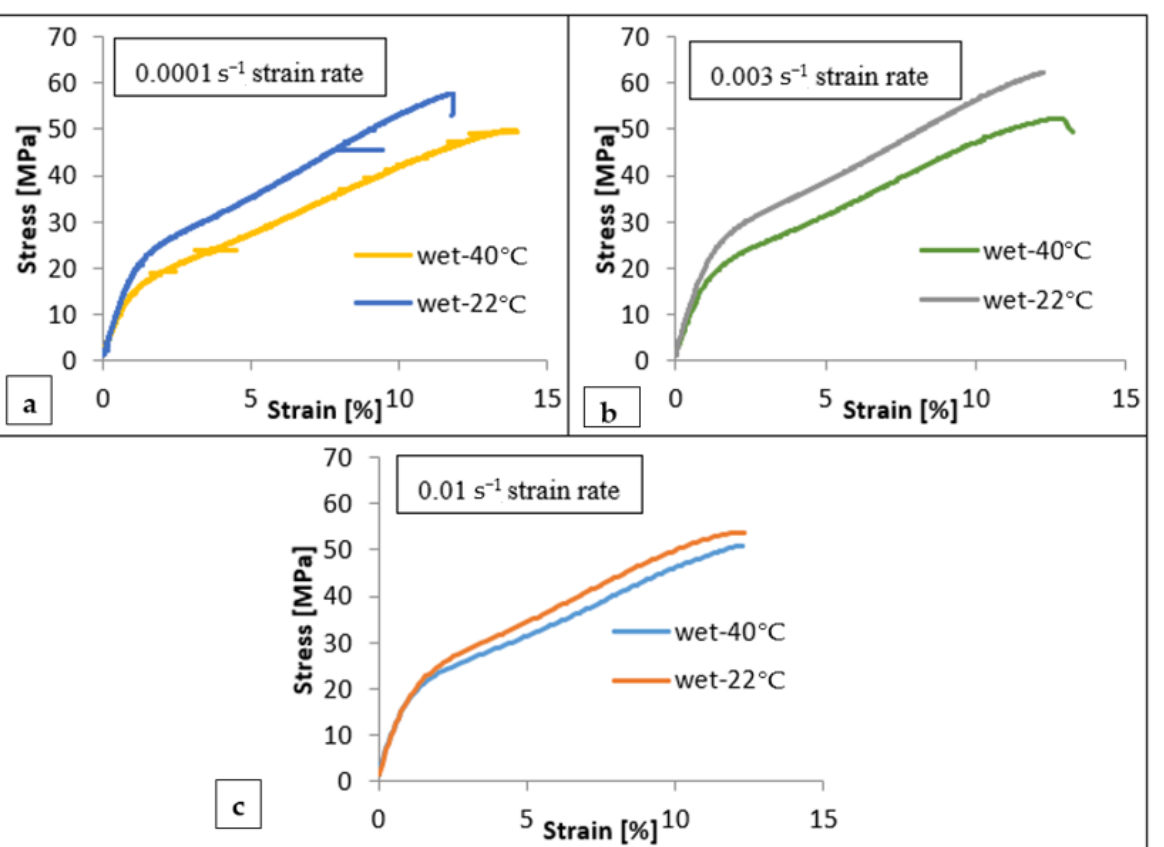
Table 4. Mechanical properties of BW30 membranes under wet (22 °C and 40 °C) conditions and different strain rates.